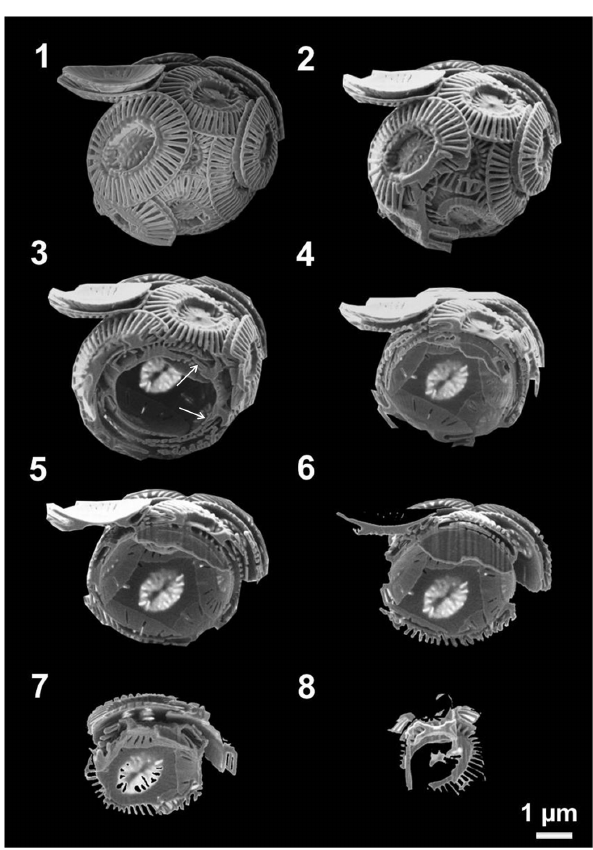
Figure 2. Six exemplary SE images of cross sections through the coccolithophore species E. huxleyi . The coccosphere in image 1 is composed of four coccolith layers and shows the highest shell thick- ness. In 2 a coccosphere composed of three coccolith layers is given. A coccosphere that indicates that the coccolith layers are not equally spread over the sphere is shown in image 3 and 4. Images 5 and 6 reveal that the shell thickness of the coccospheres is different de- pending on the number of coccolith